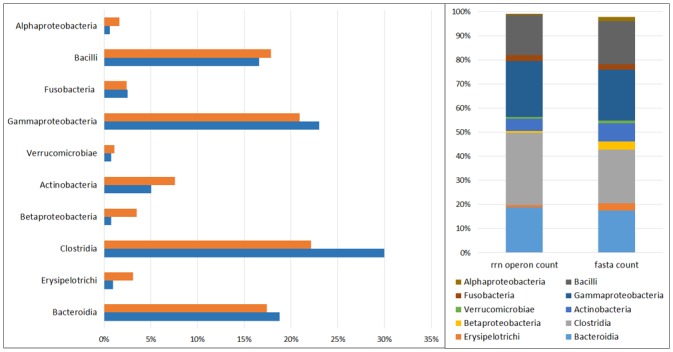
Influence and effect of rRNA gene copy number on the relative abundance of bacterial populations.Conversion of data to relative percent of population based on the number of 16s rRNA operons in each organism, thereby representing the number of bacteria or genomes, had a major effect on the composition of the bacterial communities within the mucosa and submucosa. Certain bacteria are either over or under represented when a 1:1 ratio is assumed per normal bioinformatics. Similar disparities were found at all bacterial divisions. Legend: Fasta Count: Relative abundance based on the assumption that each rRNA sequence alignment is equivalent to a single bacterial genome/cell as used in most bioinformatics analyses. rrn Operon Count: relative bacterial abundance based on the average number of rRNA operons in each bacterial cell (fasta count/rrn operons) thereby more accurately reflecting bacterial prevalence.